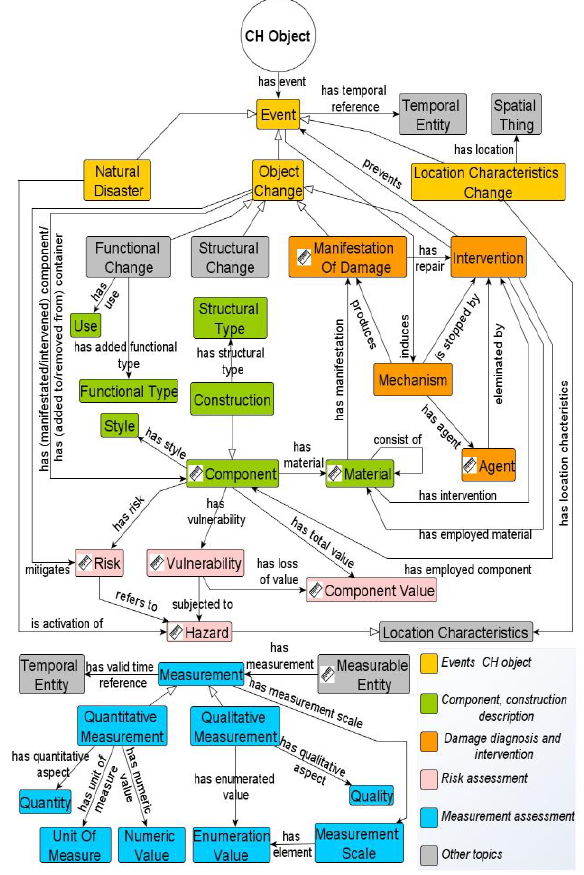
Figure 1. MONDIS Ontological